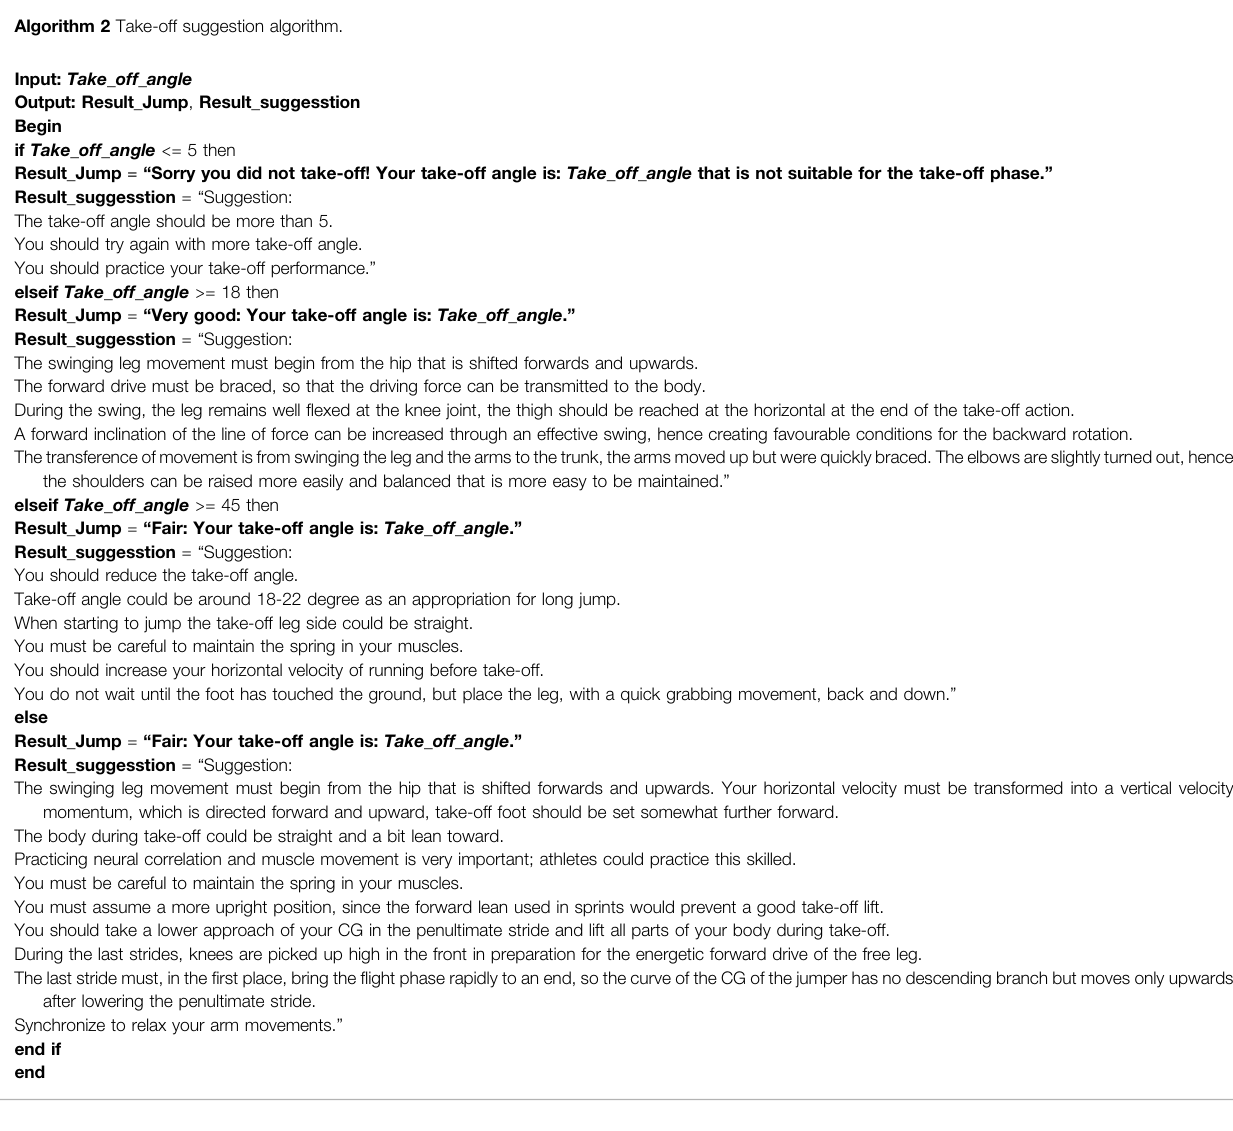
protocol for testing of the KBST system, participants performed long jump for two attempts ( Test 2 and Test 3 , respectively) with suf fi cient rest between each test. The coach acquired the results from the KBST and provided the participants with the suggestion after Test 1 and Test 2 . The starting position ( Start Position ), maximum velocity ( V max ), maximum velocity position ( V maxPosition ), and take-off angle ( θ ) were assessed from a total of all long jumps on the synthetic running track, fl at and dry. The protocol for testing of the KBST system consisted of four located markers that were M1 at the starting point of the long jump sand pit, M2 at the take-off position, M3 at 5m far from the take-off position, and M4 at 10m far from the take-off position. The fi rst camera was posited about 10m far from the take-off position ( M2 ). The second camera was posited about 25m far from the marker ( M4 ). Both cameras were fi xed on the three-way head tripod with a height about 1.5 m from the fl oor ( Figure 2 ).